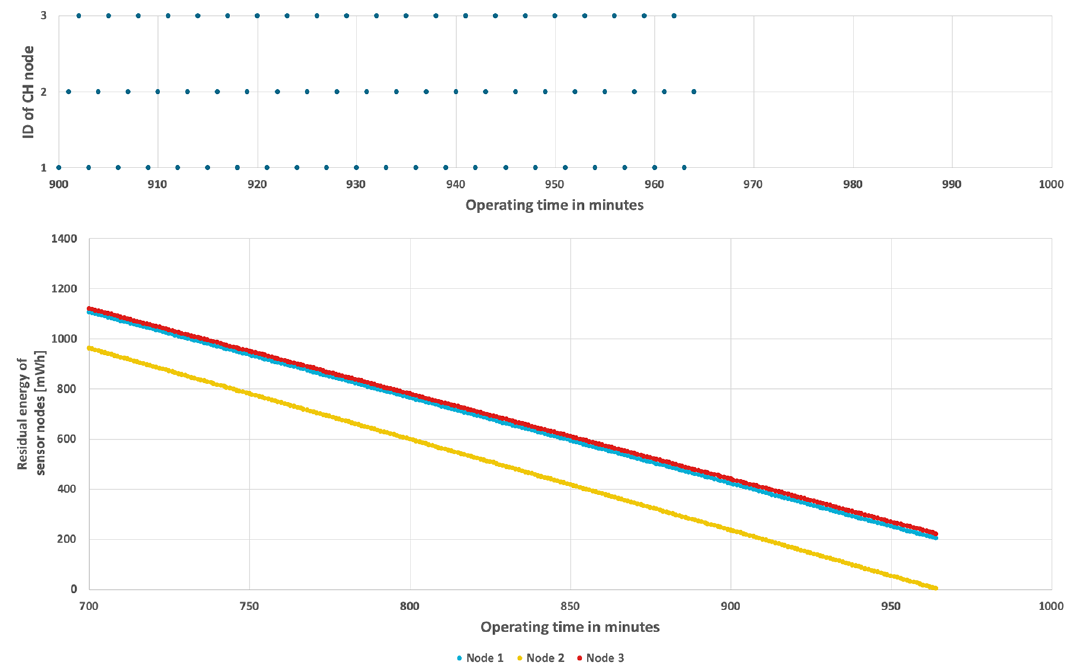
Figure 8. Energy consumption by sensor nodes for RRCR algorithm and variable probability of event occurrence.